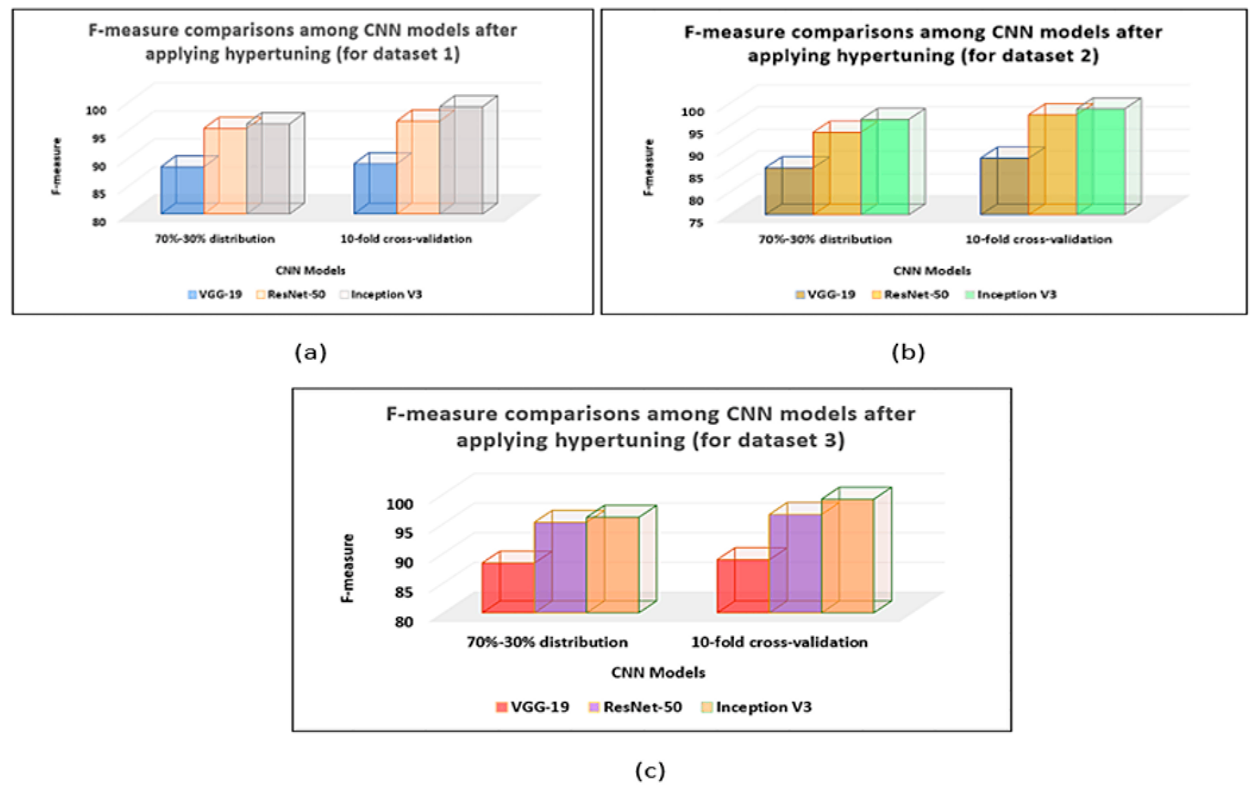
Figure 10. Comparison among VGG-19, ResNet-50, and Inception V3 in terms of F-measure for ( a ) dataset 1, ( b ) dataset 2, and ( c ) dataset 3.